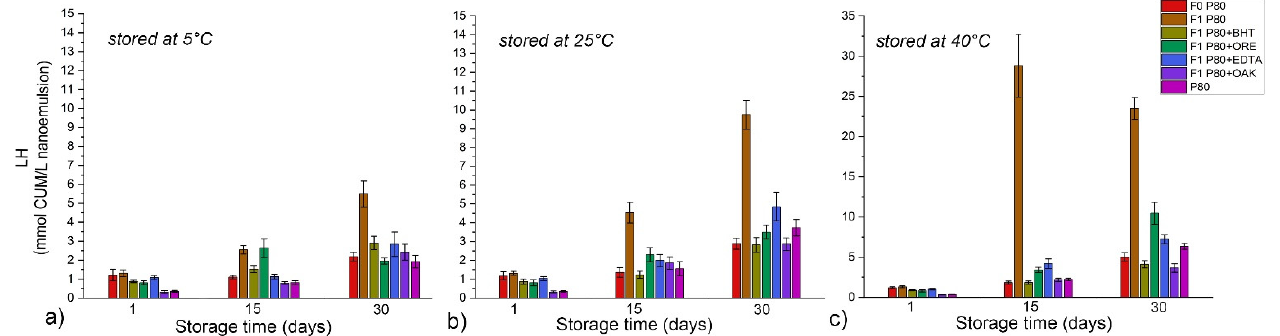
Figure 6. Lipid hydroperoxides—LH of polysorbate 80 dispersion in water (P80) and P80-stabilized NEs during one month of storage at different temperatures: ( a ) 5 °C, ( b ) 25 °C and ( c ) 40 °C. Blank na- noemulsion was prepared without raspberry seed oil—RO (F0 P80), while RO loaded NEs are marked as F1 P80; antioxidants tested in nanoemulsions were marked as: butylated hydroxytoluene—BHT, oregano essential oil—ORE, ethylenediaminetetraacetic acid disodium salt dihydrate—EDTA, or sessile oak